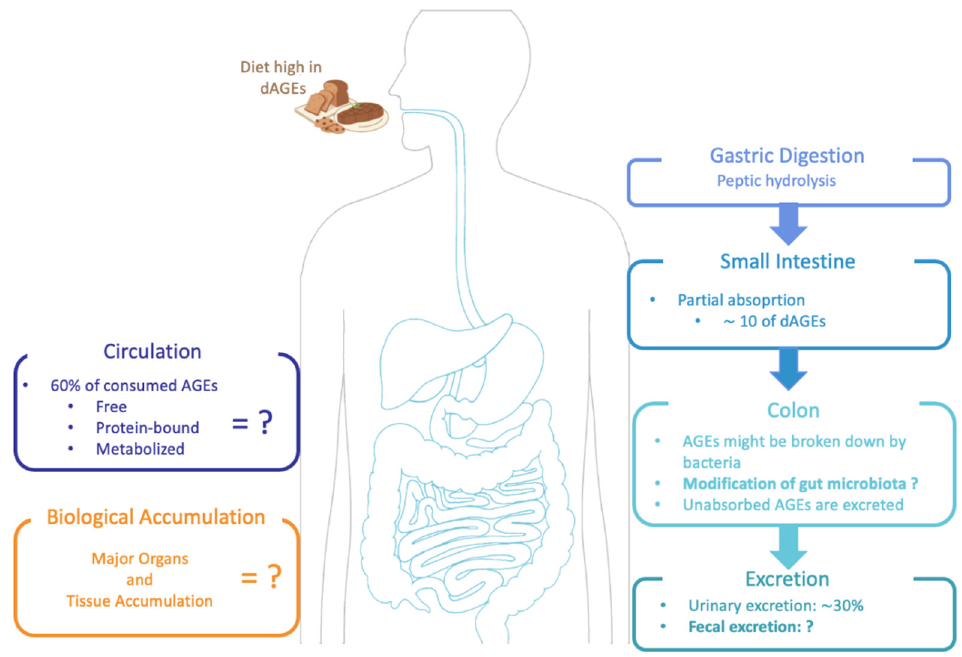
Figure 2. Suggested metabolic pathway of dAGEs: absorption, digestion and excretion in the human body.